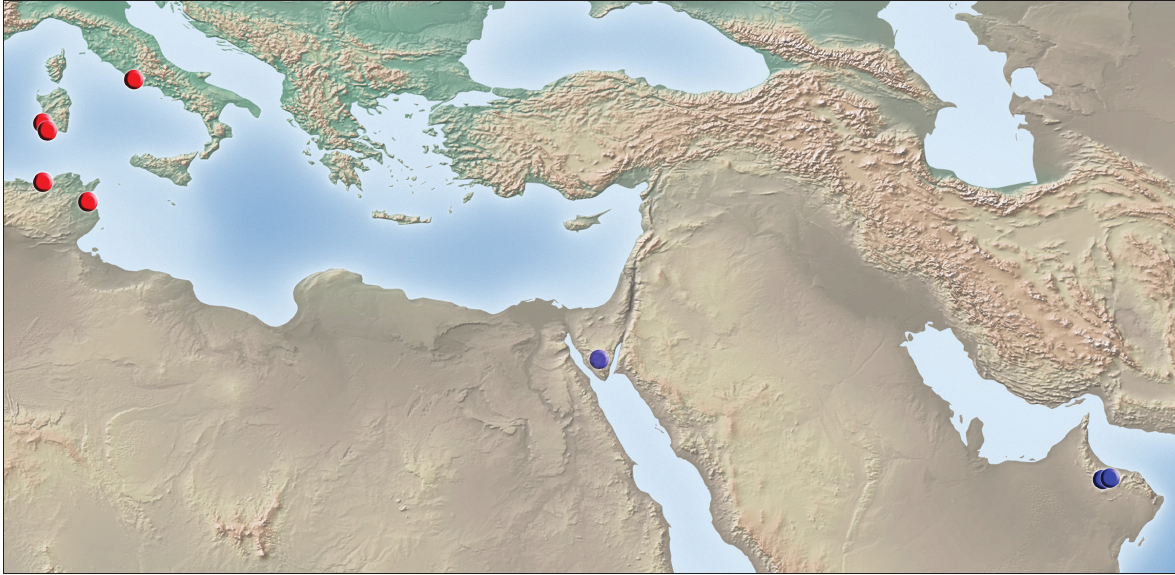
Figure 12. Distribution of Gymnocnemia mirabilis and Megistopus lucasi . Blue dots = Gymnocnemia mirabilis , red dots = Megis - topus lucasi